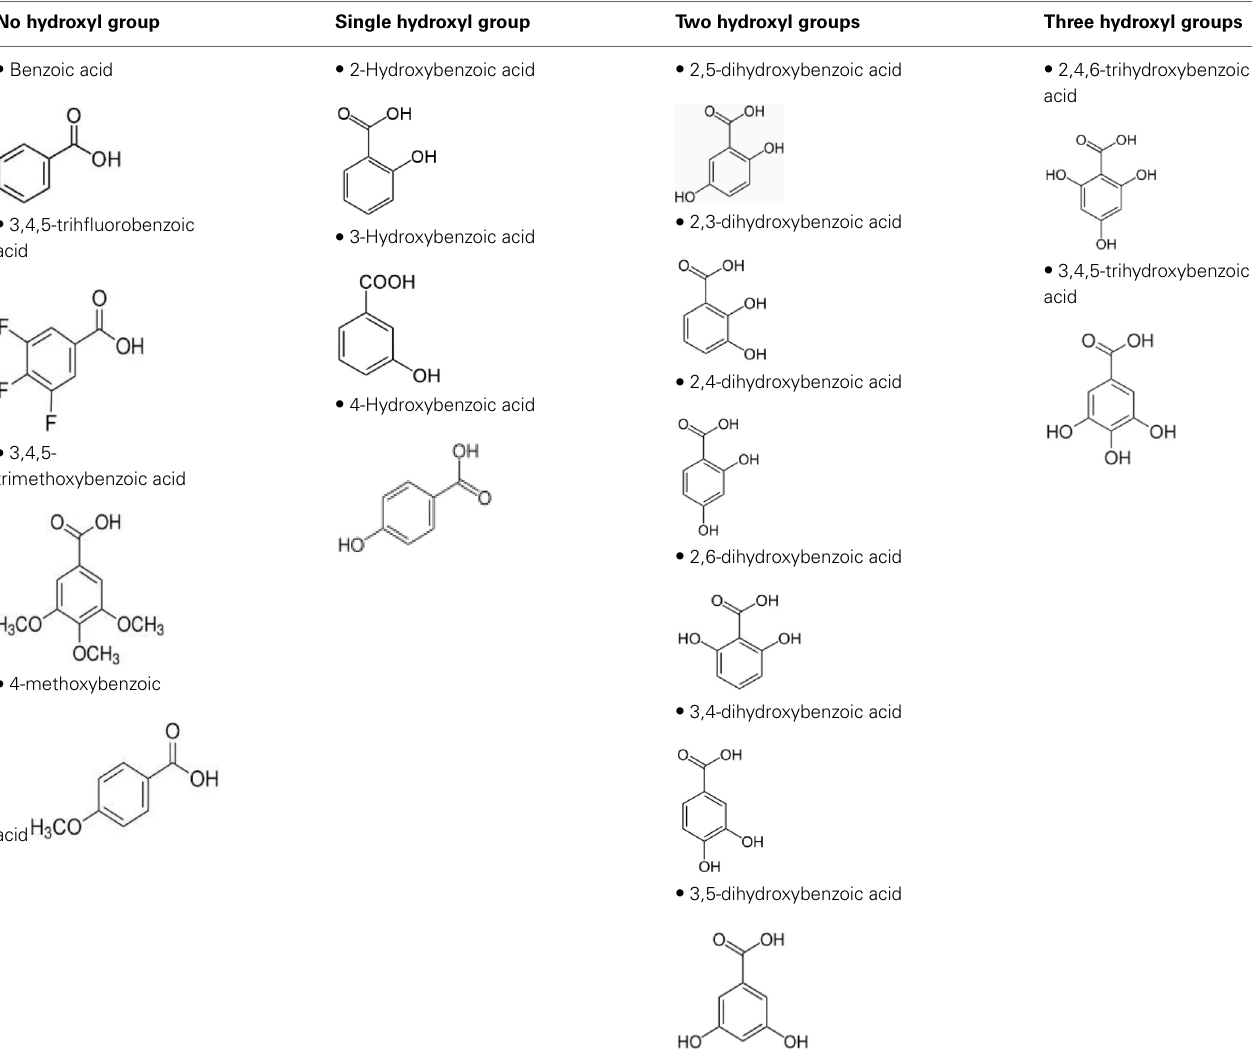
Table 2 | The compounds were divided into four groups based on the number of hydroxyl groups attached to the phenyl ring. No hydroxyl group